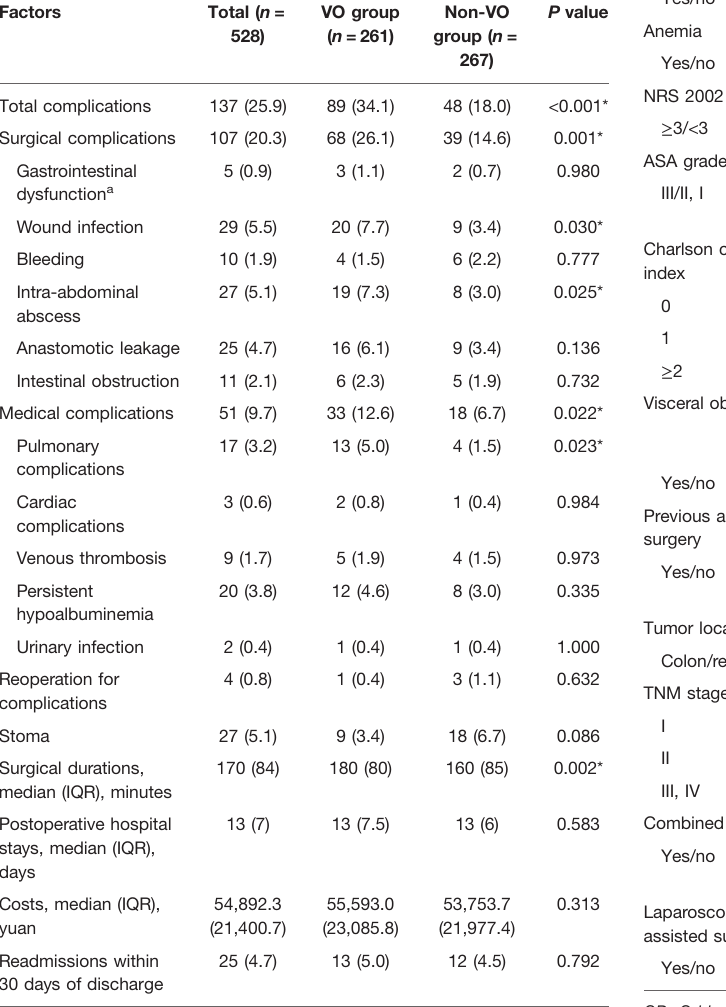
OR, Odds Ratio; CI, Con fi dence Interval; BMI, Body mass index; ASA, American Society of Anesthesiologists; TNM, tumor – node – metastasis. * Statistically signi fi cant (P <